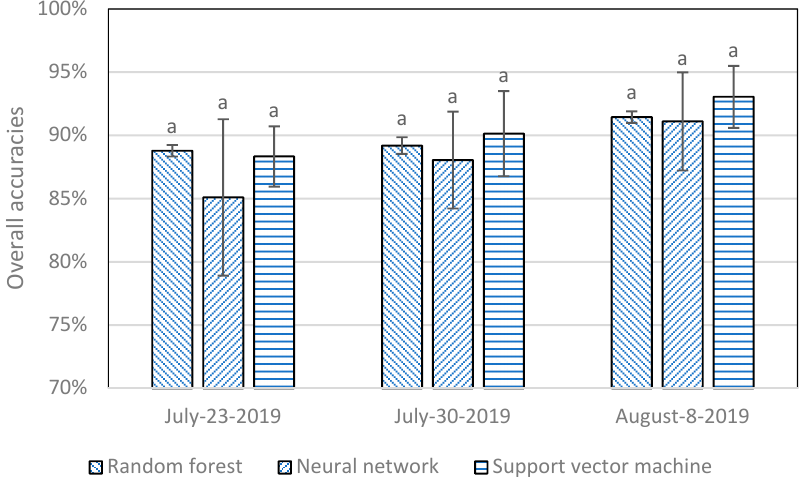
Figure 15. Accuracy comparisons of three classifiers (random forest, neural network, and support vector machine) on individual date datasets. Whiskers on bars represent two standard deviations calculated from 10 replicates. Bars with different letters are significantly different by Tukey’s test at 0.05 significance level.